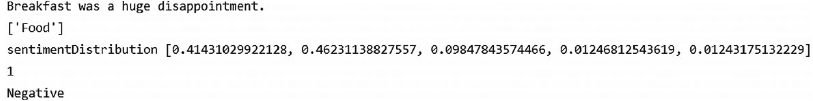
Figure 7. An example of sentiment analysis using Standford